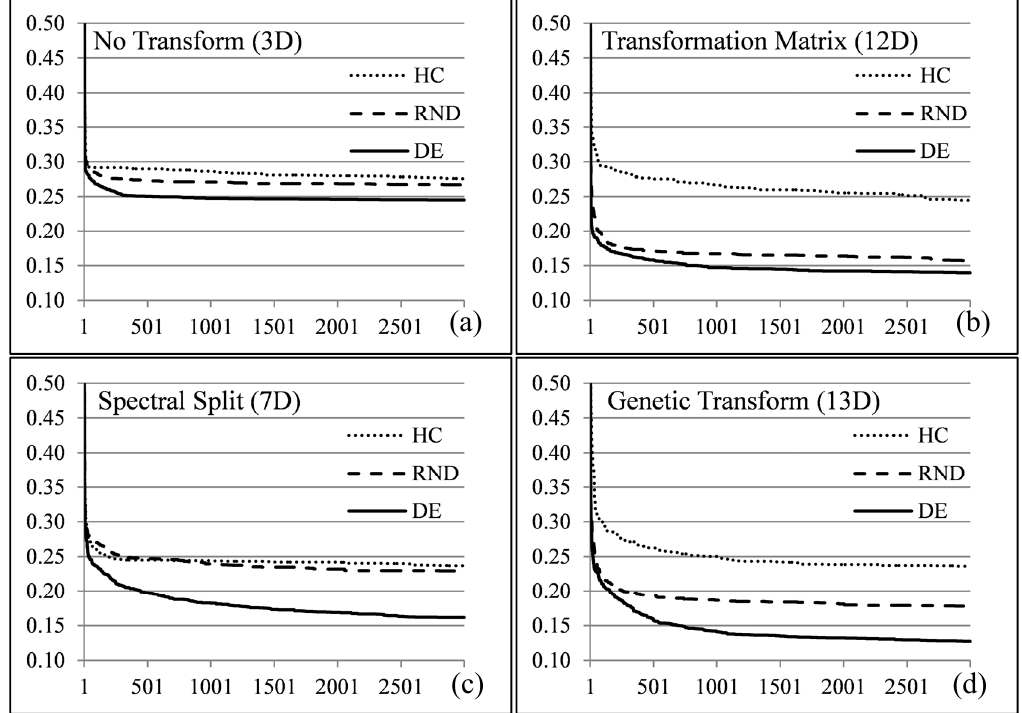
Figure 13. Fitness traces for three search methods on the Bokolmanyo site (MS segmentation) using the ( a ) No Transform, ( b ) Transformation Matrix, ( c ) Spectral Split and ( d ) Genetic Transform transformation strategies. The x-axes delineate search iterations. The y-axes delineate RWJ evaluation